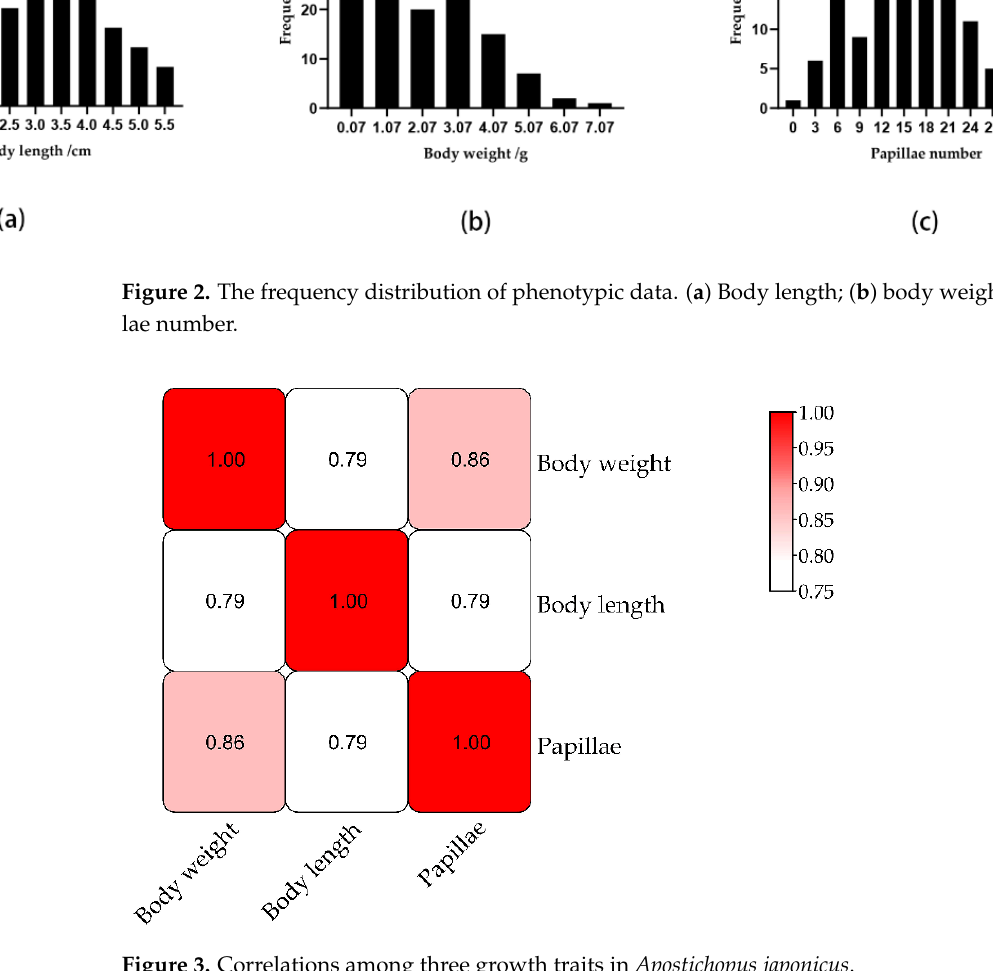
Figure 3. Correlations among three growth traits in Apostichopus japonicus .